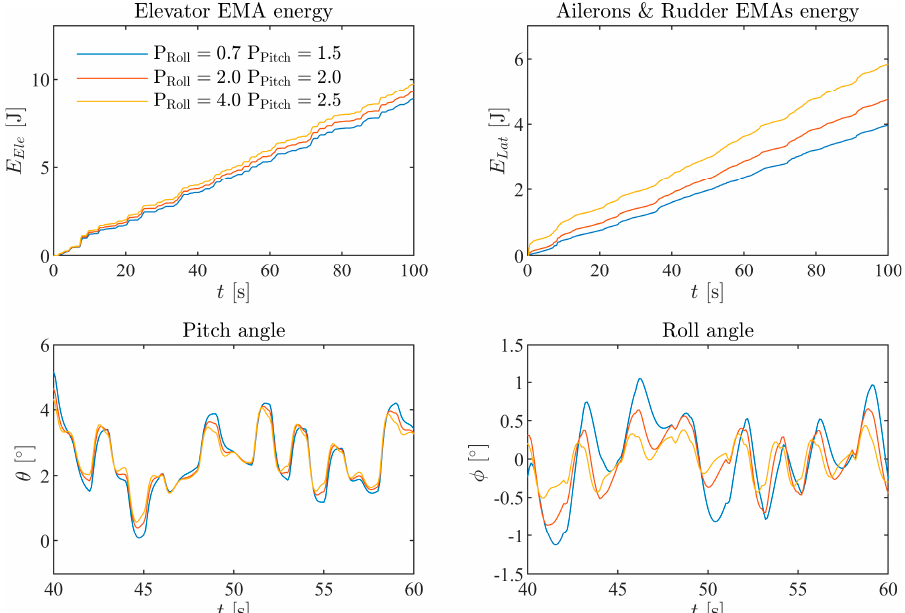
Figure 15. Longitudinal, lateral-directional EMAs energy consumption, and attitude response in turbulence (at 10 m/s intensity) for three proportional gain settings in the attitude control loop.